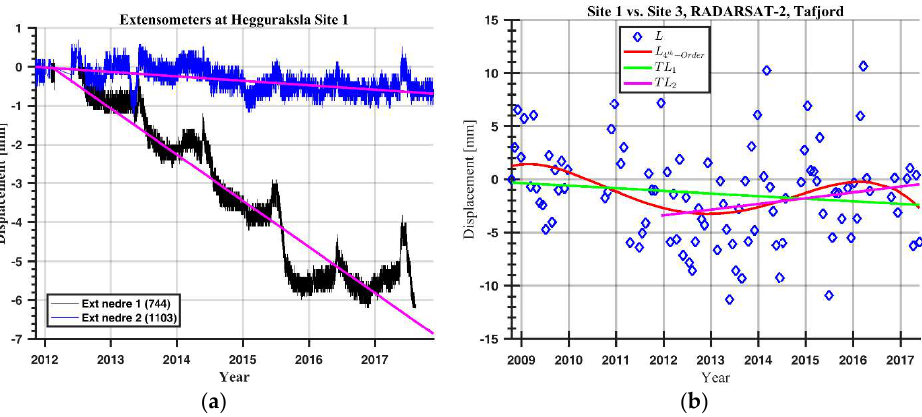
Figure 19. ( a ) Displacement as a function of time from the two extensometers mounted at Site 1. The trends show a displacement of −0.7 mm for extensometer 1 and of −6.0 mm for extensometer 2 from 6th February 2012 to 10th March 2017. The motion of extensometer 2 is believed to be partly due to failure of the mounting rods at one end. ( b ) Displacement as a function of time for the data from RADARSAT-2. The blue diamonds are the data samples, the red line is a 4th order polynomial fit, and the green line is a linear fit. The magenta line is a linear fit covering the same measurement period as the extensometers. Note that the satellite data are line-of-sight displacement and not vertical displacement.